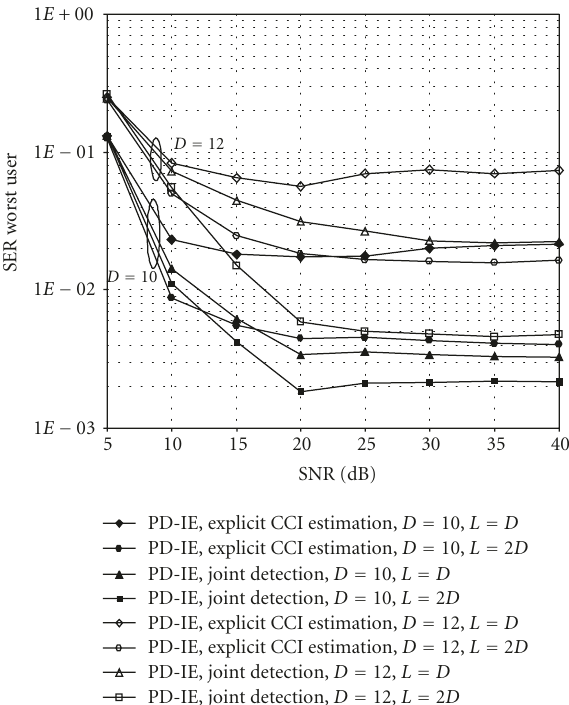
L = D and 2 D using a 5-element UCA with D = 10 and 12 users. The iteration parameters are set to give comparable complexity for PD-IE with explicit CCI estimation and PD-IE with joint detection as shown in Table